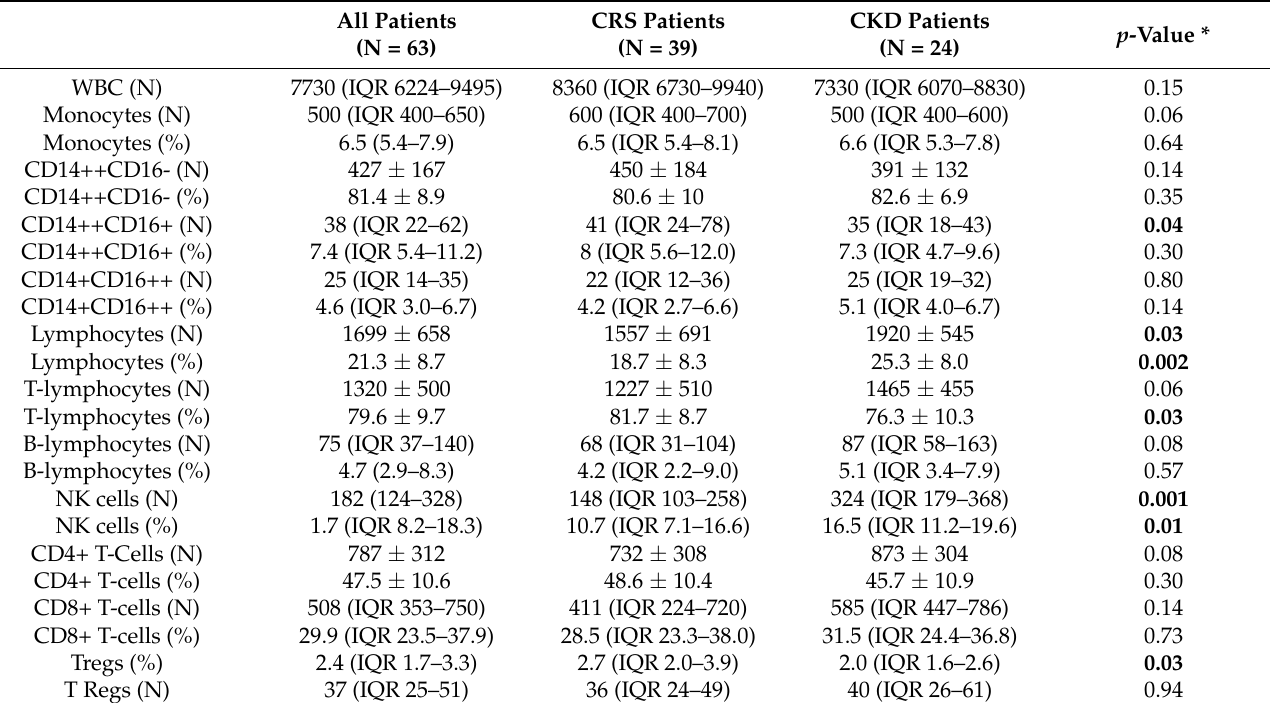
Table 2. Immune cell subpopulations in all patients, patients with type 2 CRS, and CKD patients. Statistically significant differences between subgroups are highlighted in